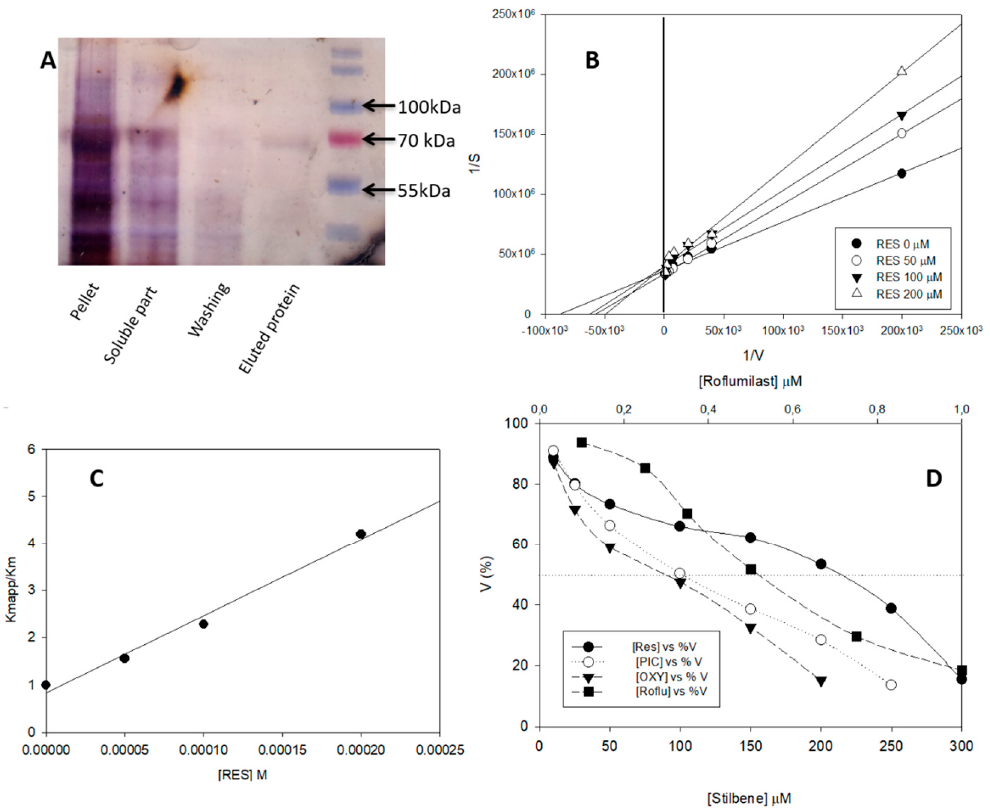
Figure 3. ( A ) SDS-Page silver staining of yPDE2 purification (enzyme MW ≈ 63 KDa); ( B ) Lineweaver– Burk plot of the effect of different RSV concentrations on yPDE2 activity (sample buffer at 25 °C); ( C ) competitive Michaelis–Menten plot (Equation (3)); ( D ) effect of different inhibitors against yPDE2 activity (sample buffer at 25 °C) using 0.08 μ M of enzyme in all